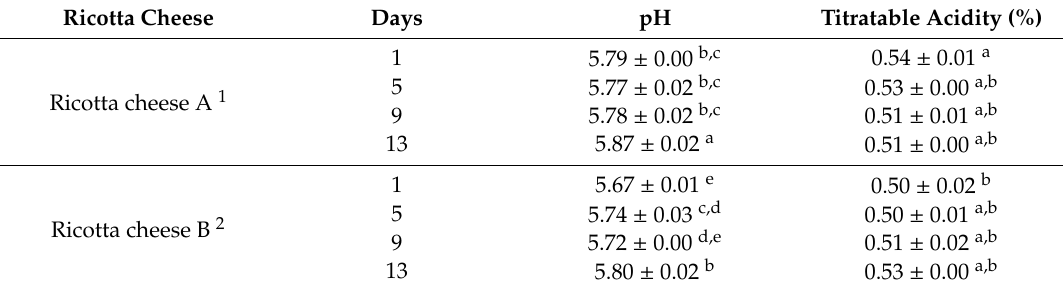
Table 5. The pH value and titratable acidity of ricotta cheese during storage (replicated for three di ff erent